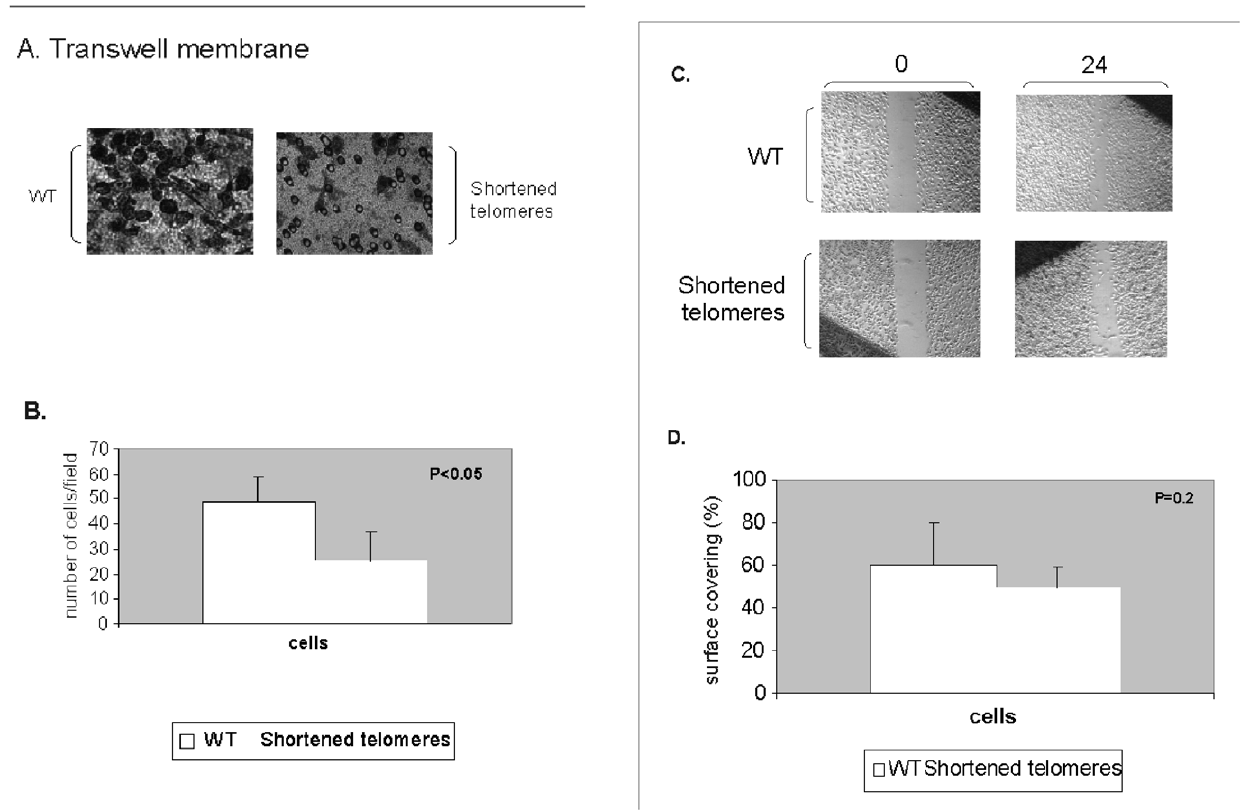
Figure 3. The migration ability of cells with shortened telomeres. The migration of cells with shortened telomeres was evaluated by the transwell and the wound healing assays. a. The transwell membrane assay. Cells with intact or shortened telomeres were allowed to migrate through a membrane for 16 hours, Gimza stained and counted. A representative picture is shown. b. Graphical demonstration of the average cell counts of four independent experiments. c. The wound healing assay. Cells with shortened telomeres were plated on Petri dishes, and the culture was ‘‘scratched’’ and followed for 24 hours. Average measurements of the cell free gaps were done. A representative example is shown. d. Graphical demonstration of the average cell counts of four independent experiments.